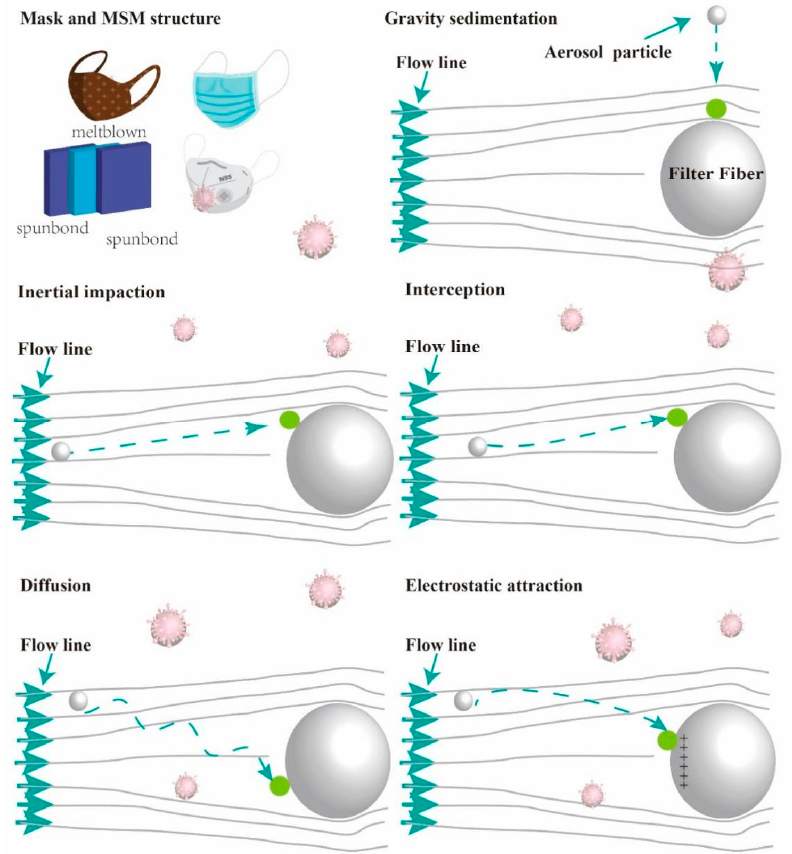
Figure 2. Filtration mechanisms, mask classification, and SMS structure.